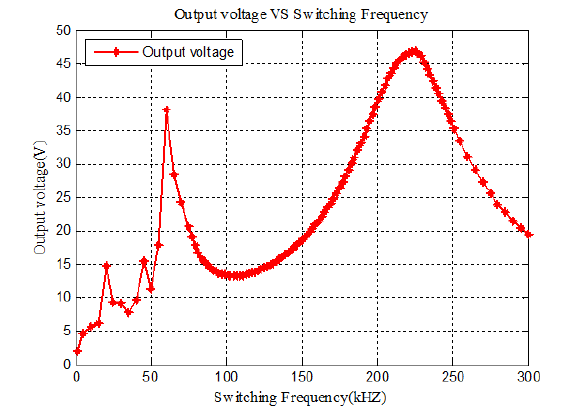
Figure 14. Output voltage vs. frequency.